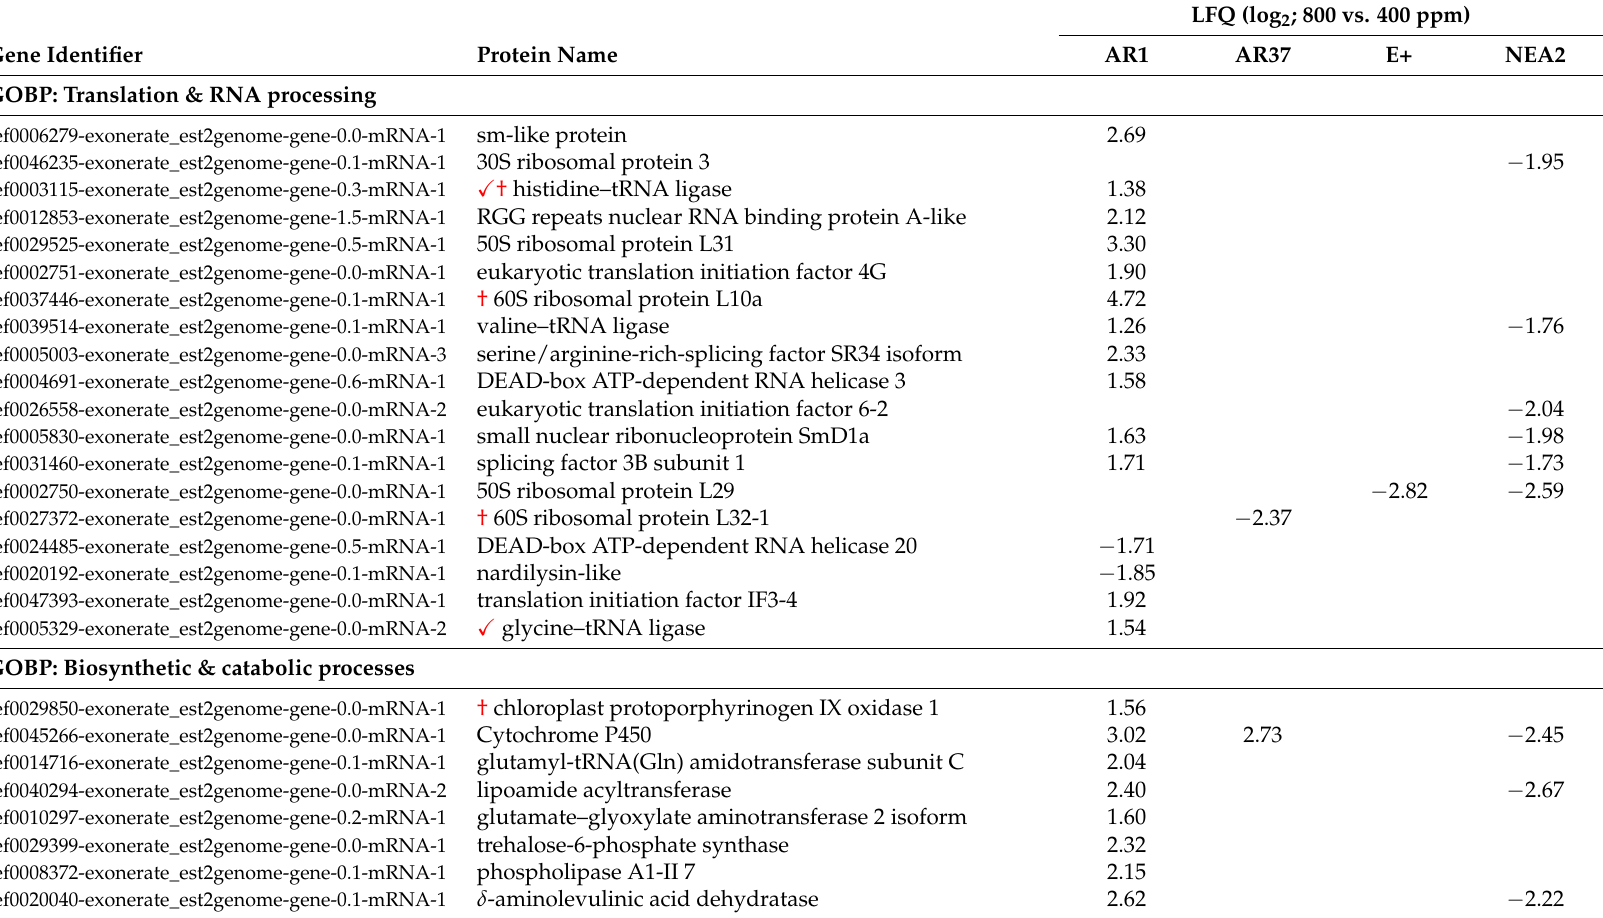
Table A4. Differences in plant proteins identified by quantitative proteomics profiling influenced by rising CO 2 levels. Proteins that load heavily in the proteome PCA are denoted with a †, see Table A2. Proteins that load heavily in the integrated OMICs PCA are denoted with a (cid:88) , see Table